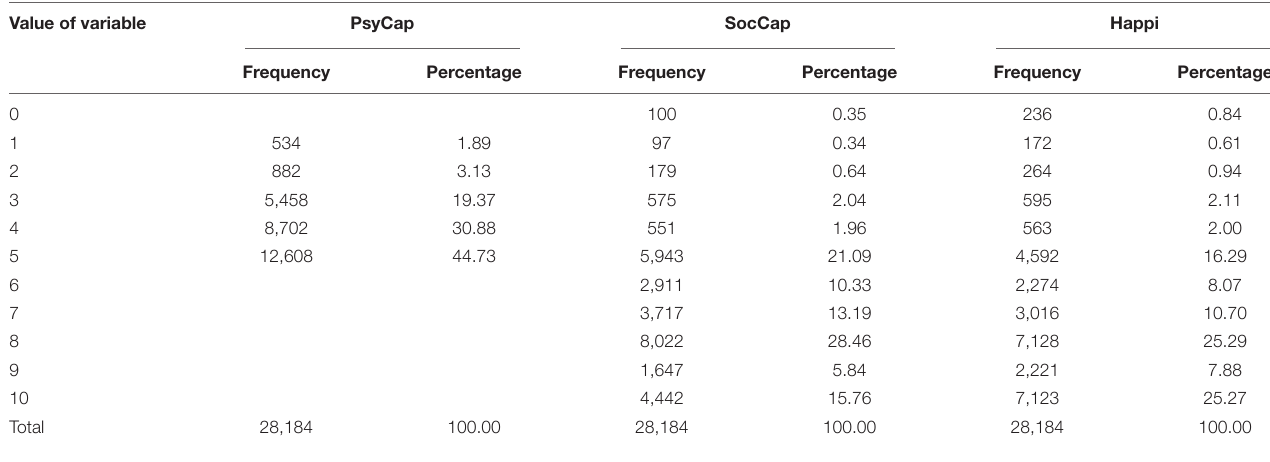
TABLE 2 | PsyCap, SocCap, and